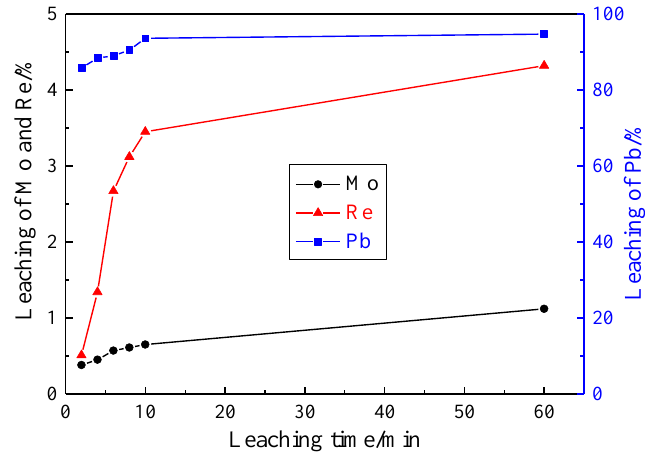
Figure 5. Effect of leaching time on the leaching of Mo, Re and Pb.